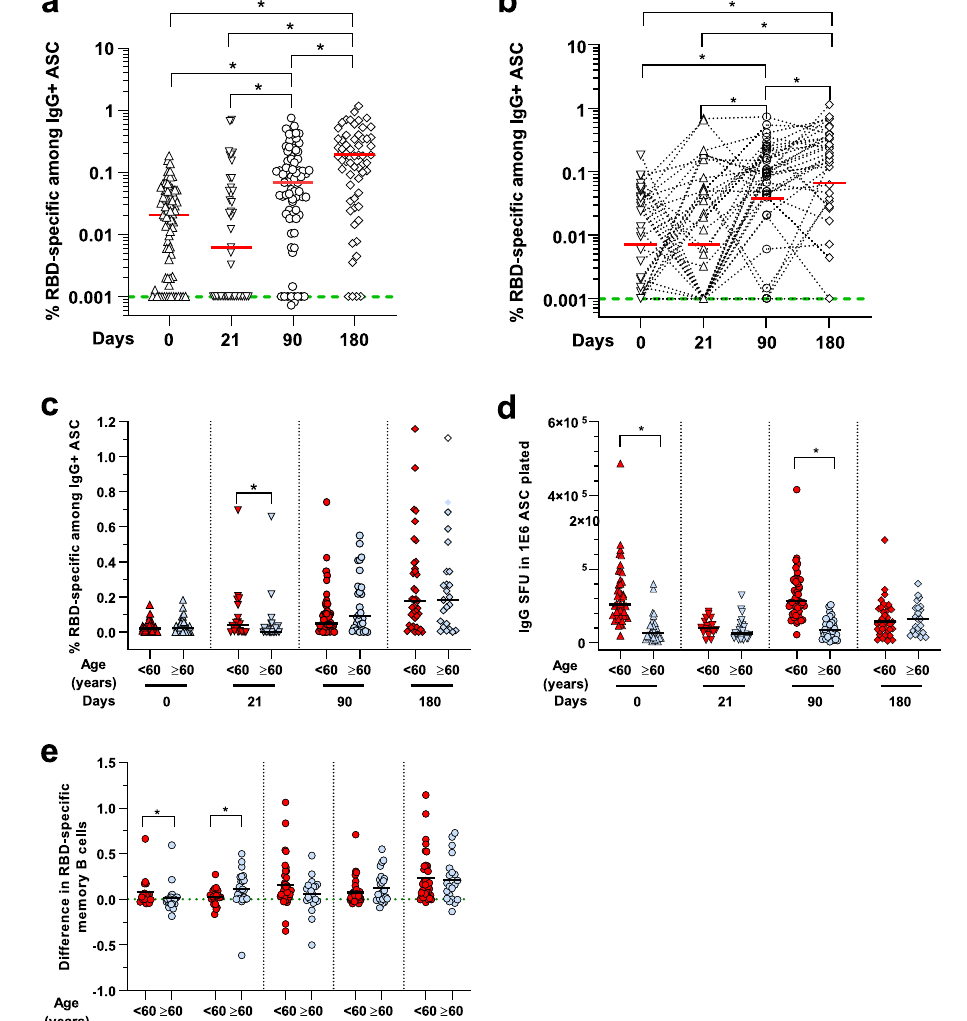
Fig.4|CirculatingRBD-speci fi cmemoryBcellsaftervaccination.a RBD-speci fi c memoryBcellsweredeterminedbyELISPOTusingaRBDprotein.Determinationof %RBD-speci fi cmemoryBcellsamongIgG+antibody-secretingcells(ASC)doneon PBMC from vaccinated participants at baseline or day 0 ( n =73), at day 21 ( n =43), at day 90 ( n =76) and at day 180 ( n =60). The median value of each group is represented by a red line and were at day 0, 21, 90 and 180, respectively 0,02%, 0.006%, 0.07% and 0.18% of the % RBD-speci fi c memory B cells among IgG+ ASC. * p <0.01, Dunn ’ s test after Kruskal – Wallis ( p <0.001) on log-transformed data. Green dotted lines indicate the limit of detection for the assay. b Paired wise comparison of % RBD-speci fi c memory B cells among IgG+ ASC for the analyzed